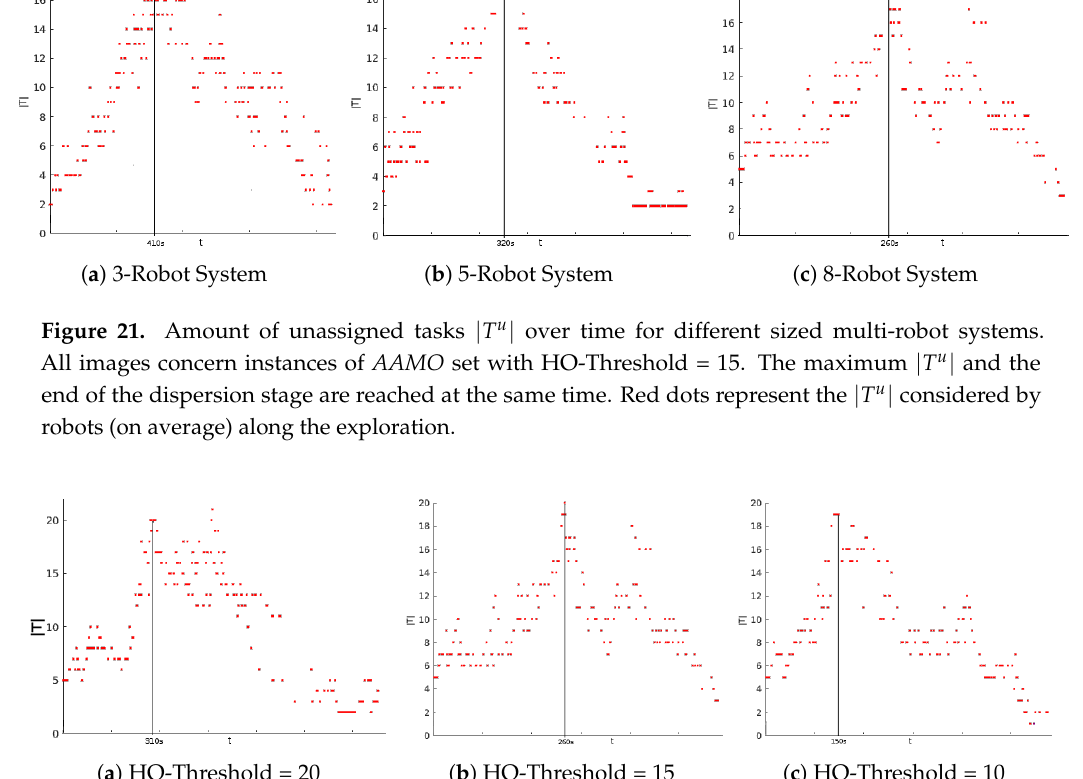
Figure 22. Number of unassigned tasks on 8-Robot systems. The maximum time. Red dots represent the